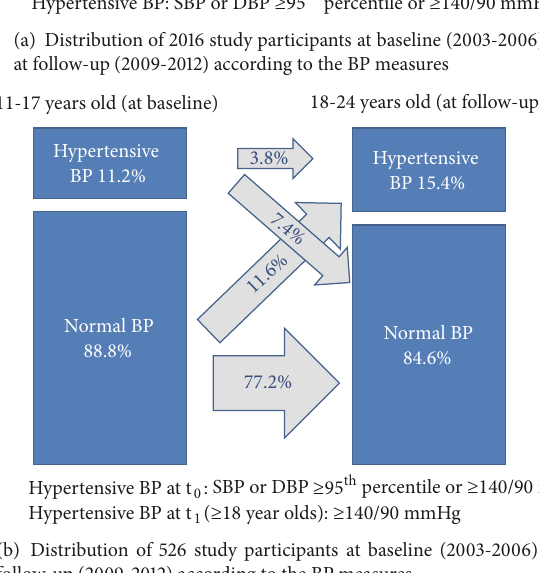
Figure 1: Blood pressure in 2542 study participants at baseline (2003-2006) and at follow-up (2009-2012).